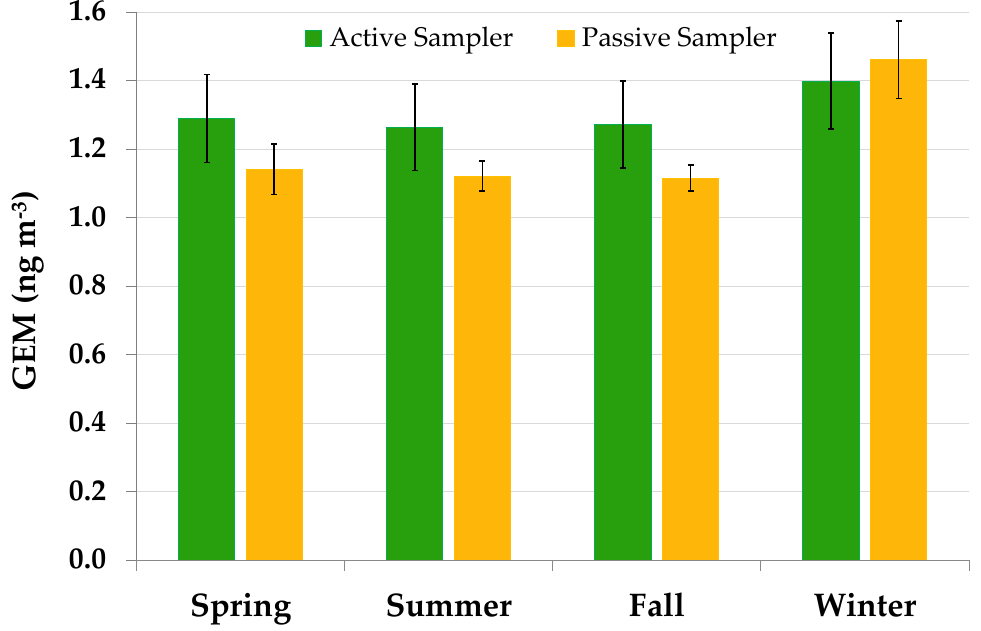
Figure 5. GEM concentrations determined using passive and active sampling at Grand Bay NERR. Error bars for passive sampler data represent 95% confidence intervals. Bars for the active sampler data represent 10% measurement error.